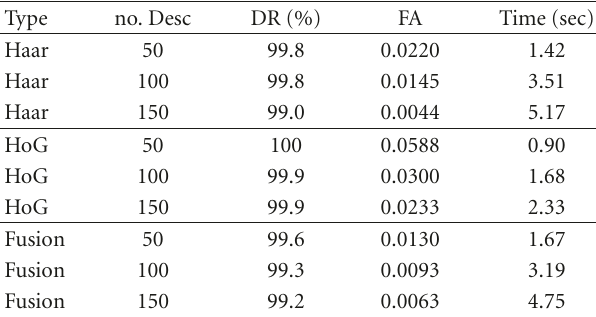
Table 1: Table of results for single